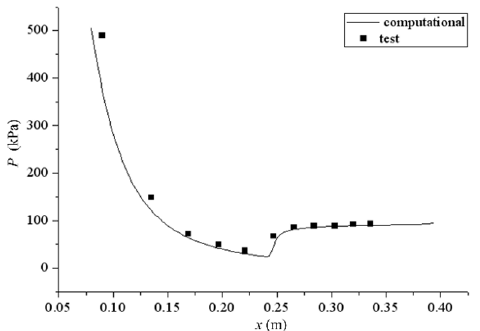
Figure 13. Comparison of numerical calculation and experimental wall pressures, Pc = 4.34 MPa.